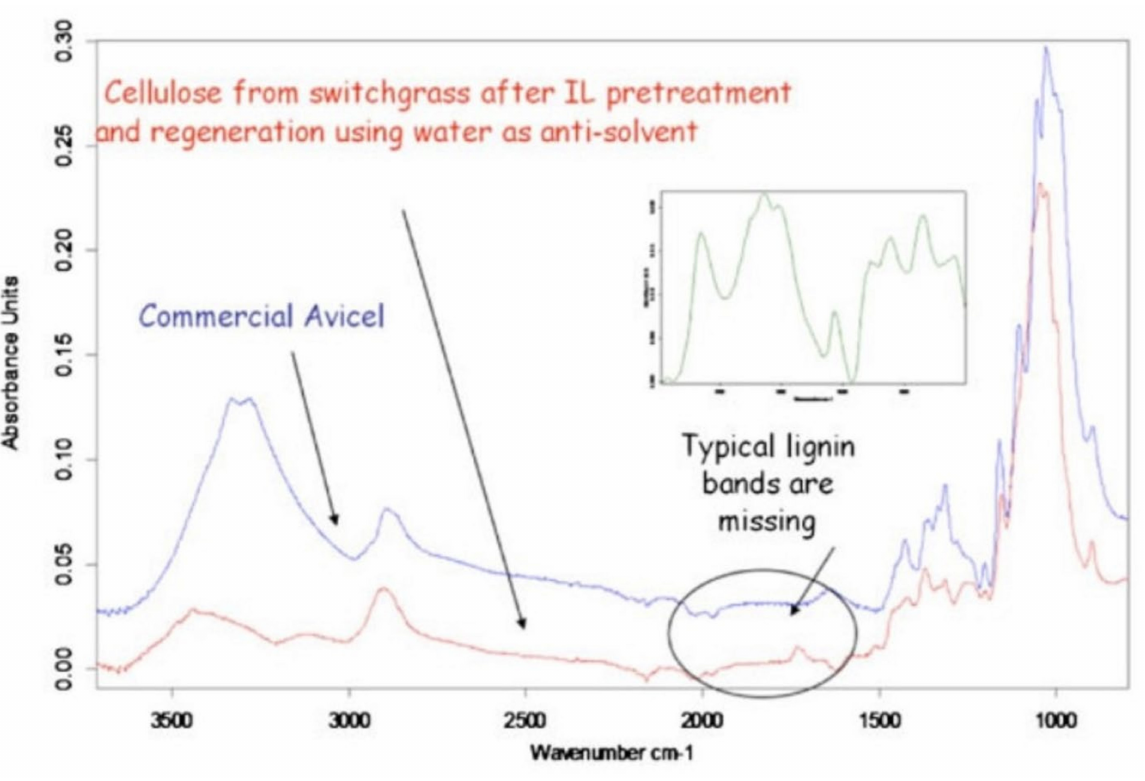
Figure 10. The FTIR spectra of the regenerated cellulose using water. Reprinted with permission from Ref. [111]. License Number: